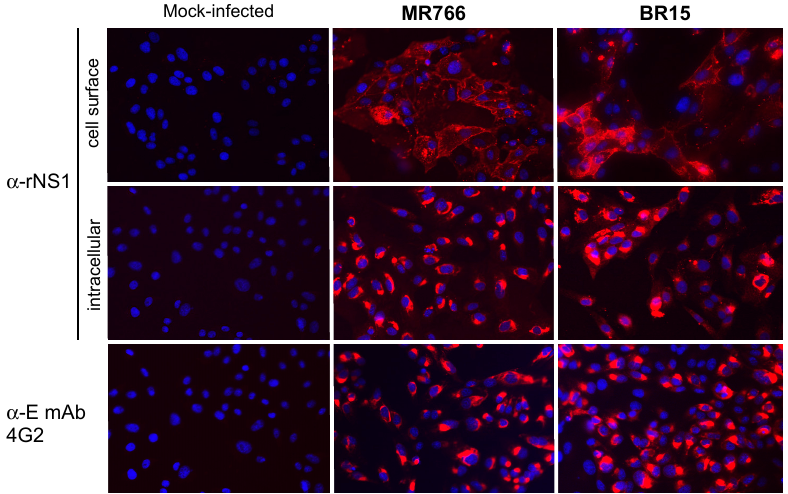
Figure 5. Reactivity of rat anti-rNS1 immune serum against NS1 synthesized in Vero cells infected by different strains of ZIKV. Vero cells were infected with MR766 and BR15 or mock-infected. Cells were fixed with PFA and permeabilized (intracellular) or not permeabilized (cell surface) with non-ionic detergent, and incubated with rat anti-rNS1 immune serum at dilution 1:2000. The anti-E mAb 4G2 served as a control of ZIKV infection. Nuclei were stained with DAPI. Magnification: × 400. The reactivity of rat anti-rNS1 immune serum was evaluated by immunoblotting on RIPA lysates of Vero cells infected with historical strain MR766, or epidemic strains BR15 and PF-25013-18 of ZIKV (Figure 6). The NS1 proteins from BR15 and PF-25013-18 share 100% of amino acid identity. Infection with YFV was confirmed by immunoblot assay using anti-E mAb 4G2 (Figure S3). Immunoblot assay using